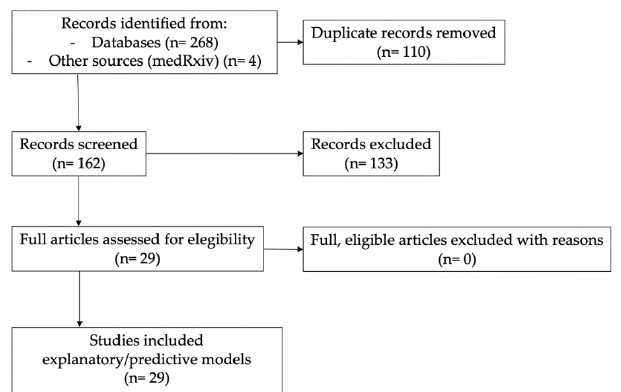
Figure 1. Flow diagram for the literature search and study selection.